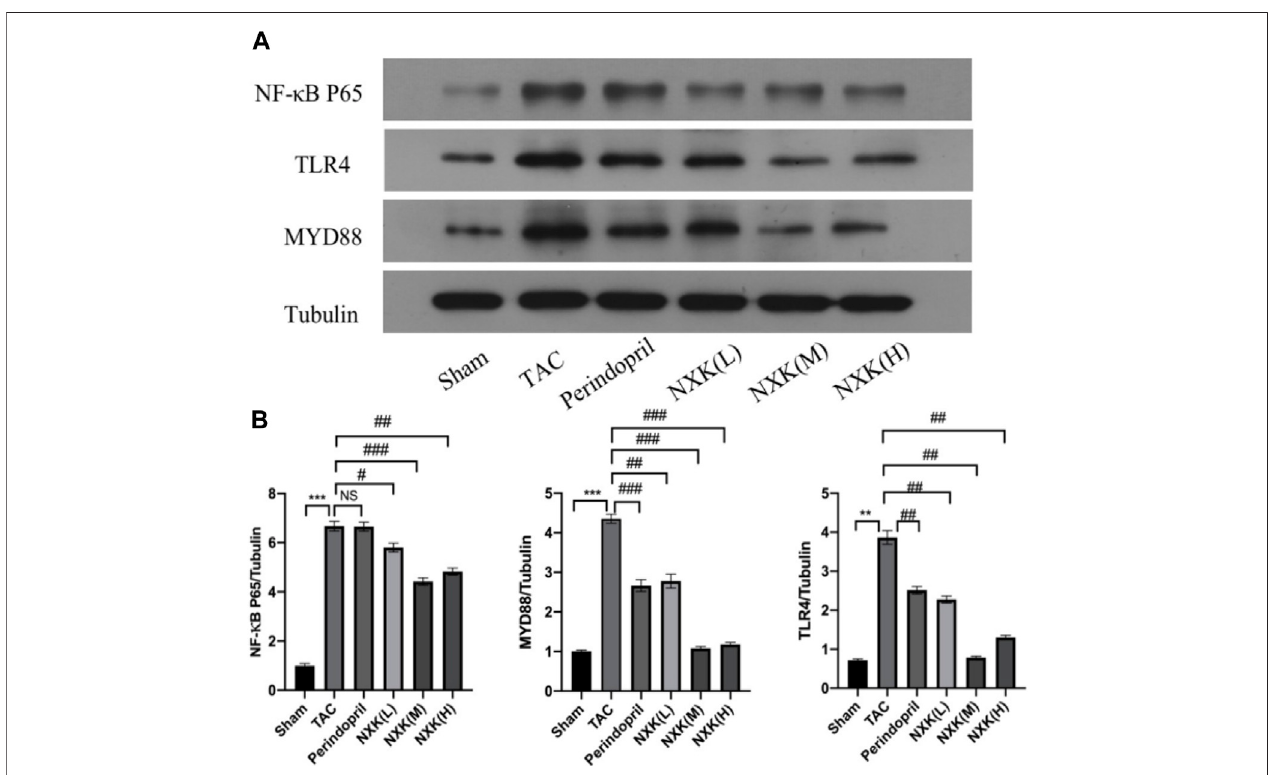
FIGURE4| Western blot analysiswasused tomeasure theprotein level ofTLR4/NF- κ Bpathway proteins. (A) Expression ofTLR4, MyD88,NF- κ Bp65proteins in different mice groups ( n = 10 per group). (B) Quanti fi cation was performed after normalization to Tubulin. Values are shown as means ± SD, < 0.05, compared to